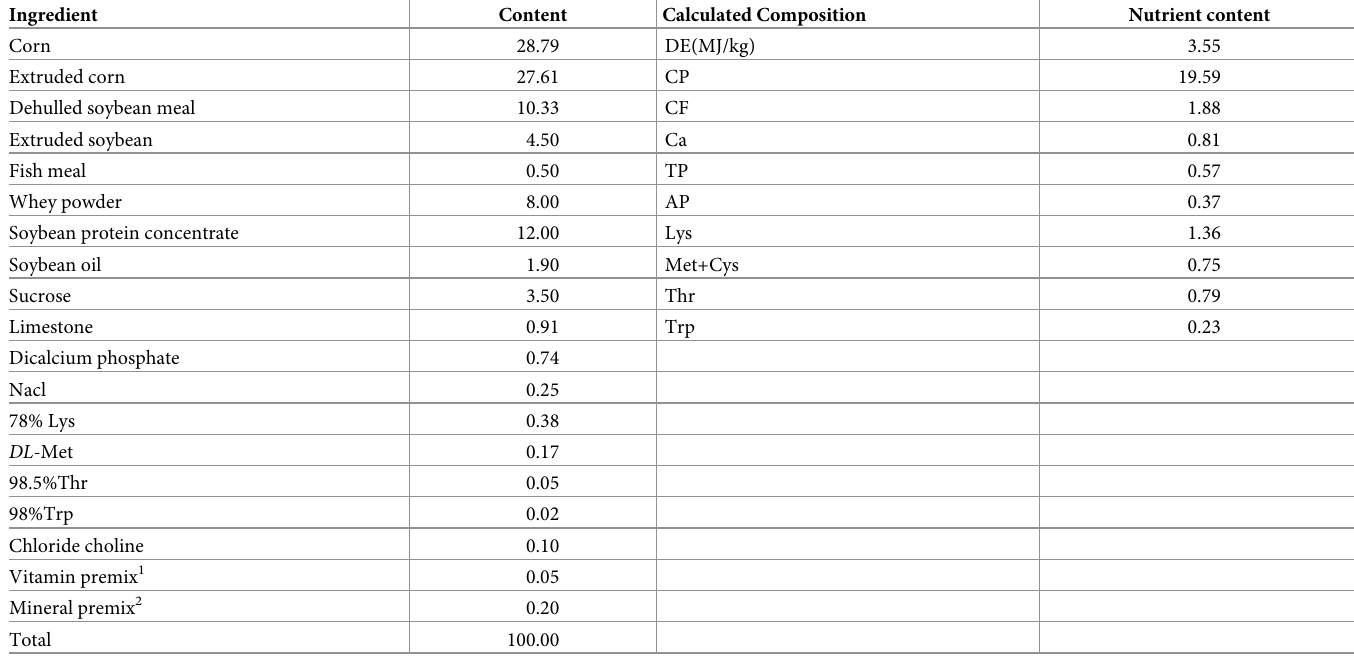
Table 1. Composition and nutrient level of experimental diets (air dry basis